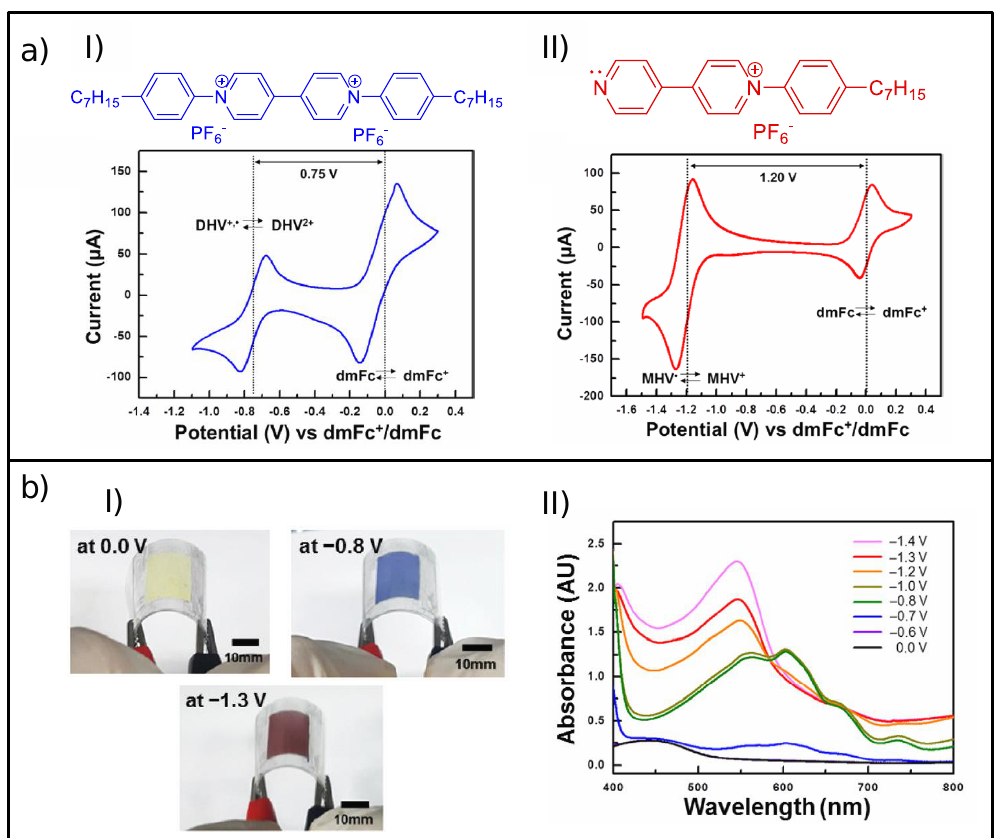
Figure 12. ( a ) Single-viologen–based EC systems: ( I ) chemical structures of diheptyl viologen dihexafluorophosphate (DHV) and ( II ) monoheptyl viologen dihexafluorophosphate (MHV) (top), along with the registered cyclic voltammograms for their corresponding gel-based ECDs at a scan rate of 20 mV/s (bottom). (Pt disk, Ag wire, and ITO-coated glass were employed as the working, reference, and counter electrode, respectively.) ( b ) Blended system comprising a molar ratio of 80/20 (MHV + /DHV 2+ ): ( I ) photographs of the voltage-tunable flexible ECDs at different applied potentials 0.0 V, −0.8 V and −1.3 V, and ( II ) applied voltage dependence of the absorption spectra. Adapted with permission from [95], copyright (2017) American Chemical Society.